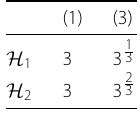
Table 1 Upper bounds for the hypergraphs H 1 and H